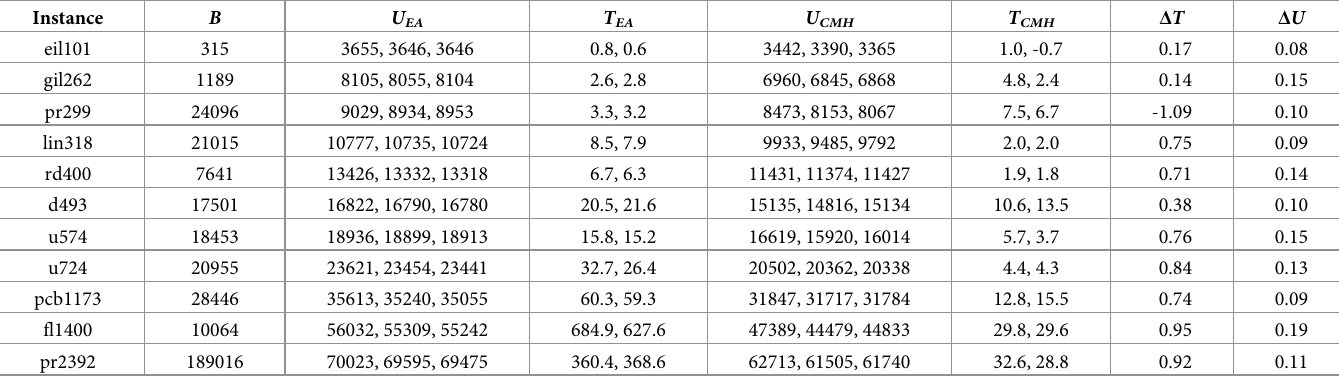
Table 2. Performance of EA4OP as standalone algorithm and when used in the clustering metaheuristic ( Random instances).